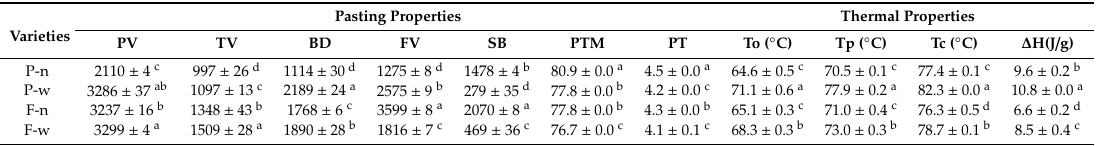
Table 4. Pasting and thermal properties of starches.